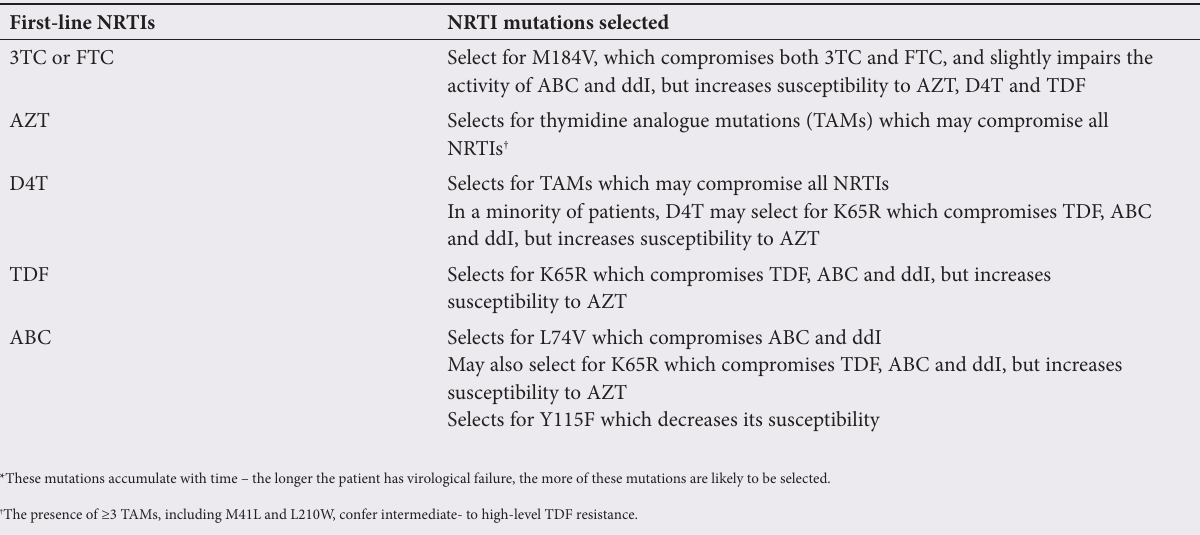
Table 4. Mutations selected by first-line NRTI combinations * First-line NRTIs